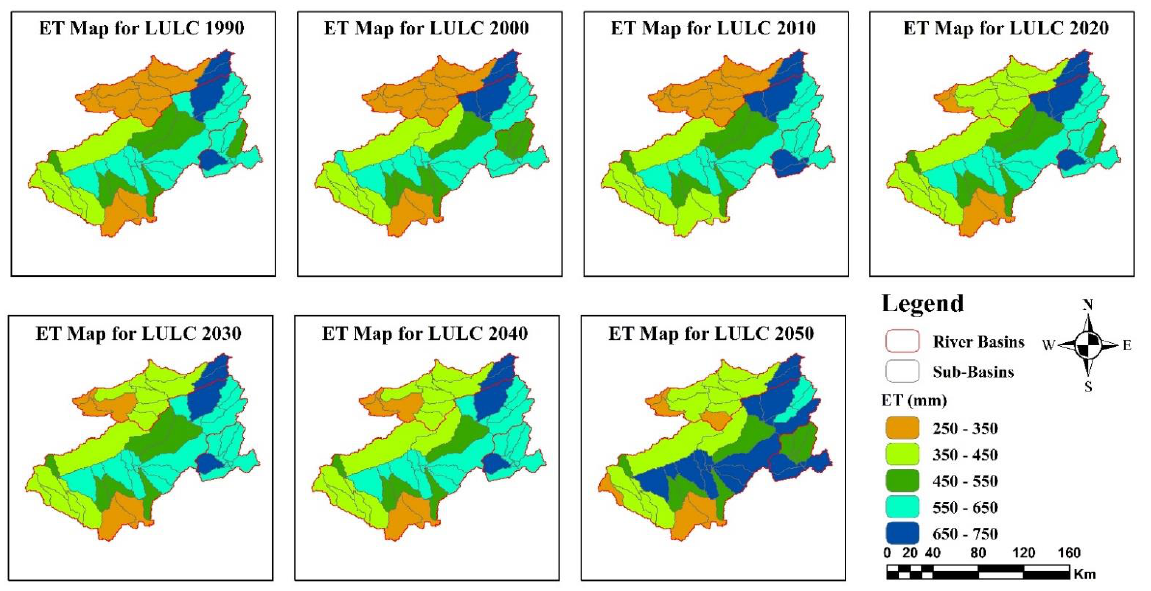
Figure 7. Spatial and temporal distribution of variations in simulated evapotranspiration.